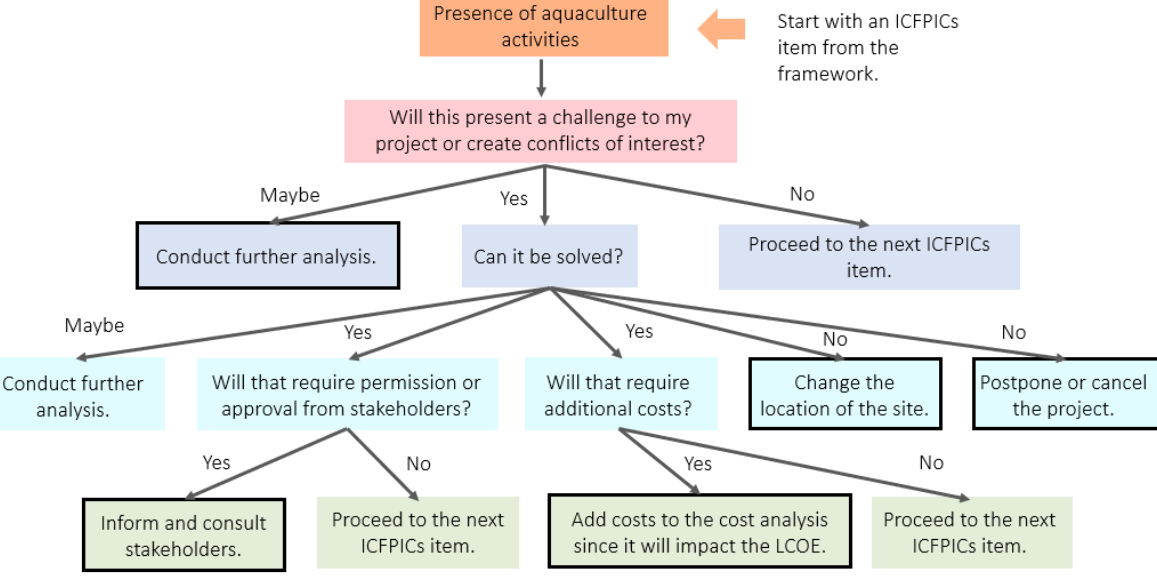
Figure 3. Decision tree exemplifying the process of utilizing the ICFPICs for a wave energy project in the Pacific environment; highlighted boxes are the main outcomes from the process.